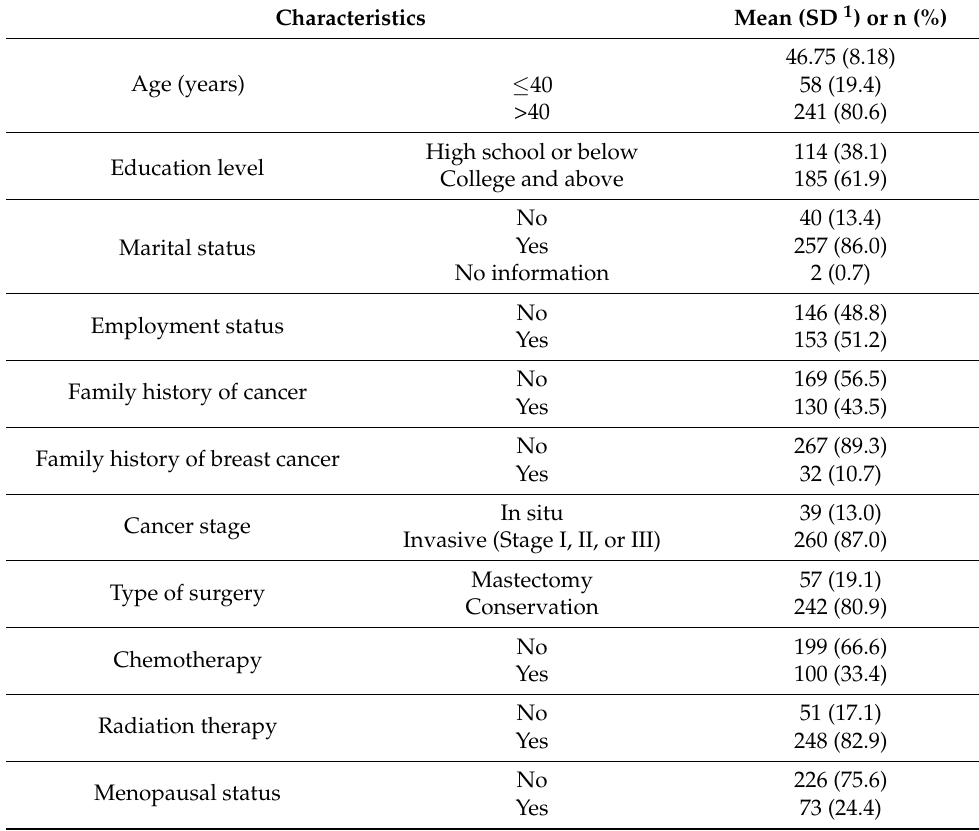
Table 2. Patient demographic and clinical characteristics ( n =